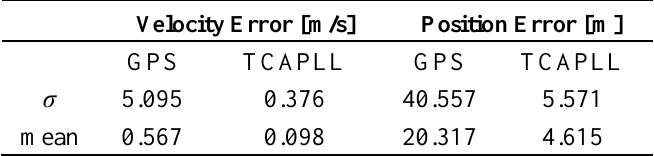
Table 4. Standard deviation and mean of the velocity and position errors when only 4 SVs are visible.